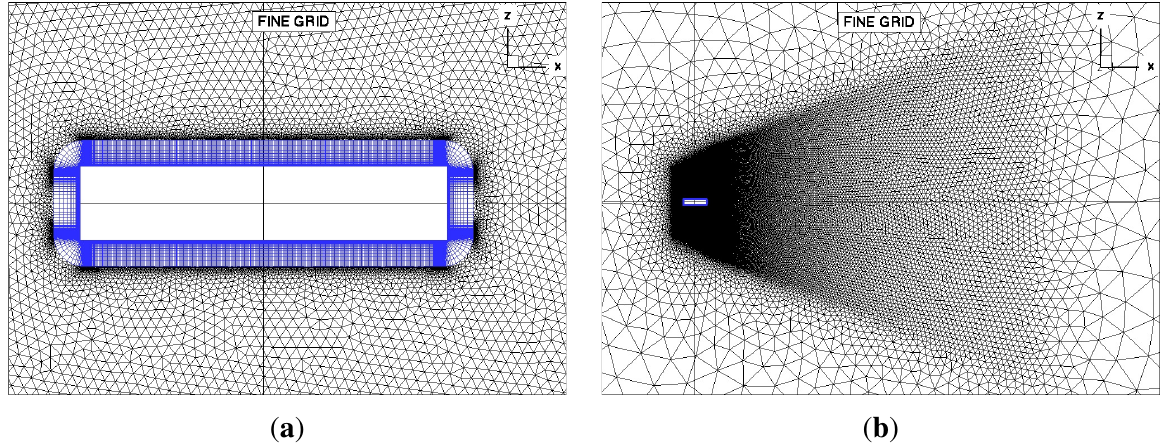
Figure 3. Near body ( a ) and wake refinement ( b ) close-ups of the grid used for the 2D rectangular 5:1 section.